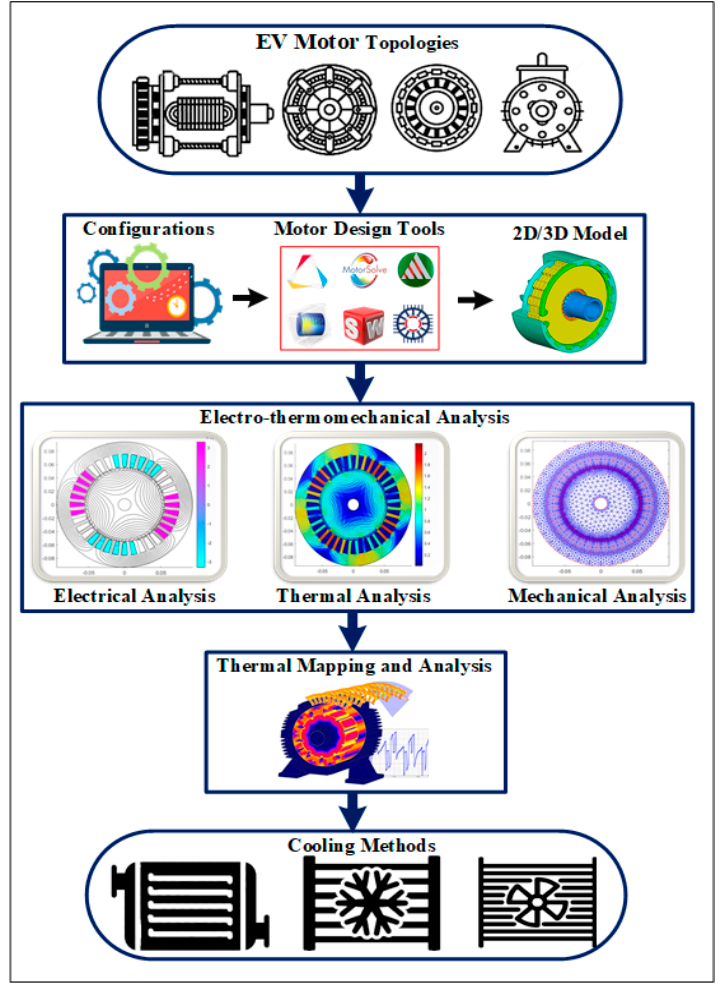
Figure 2. Proposed review perception.